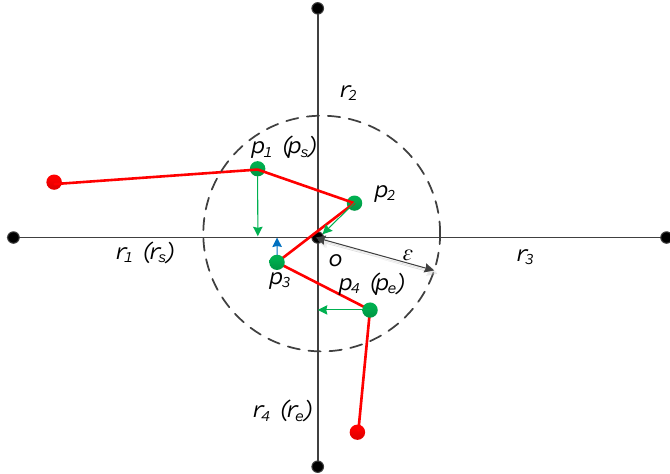
Figure 4. Intersection trajectory point matching abnormity. Points p 1 , p 2 , p 3 , and p 4 are matched to r 1 ( r s ), o , r 1 ( r s ), and r 4 (r e ), respectively. Thus, the matched trajectory sequence is ( r s , o , r s , r e ), which suggests that the trajectory is retraced in road section r s . Since this is an incorrect retrace, it is necessary to transform such disorder into an orderly sequence.